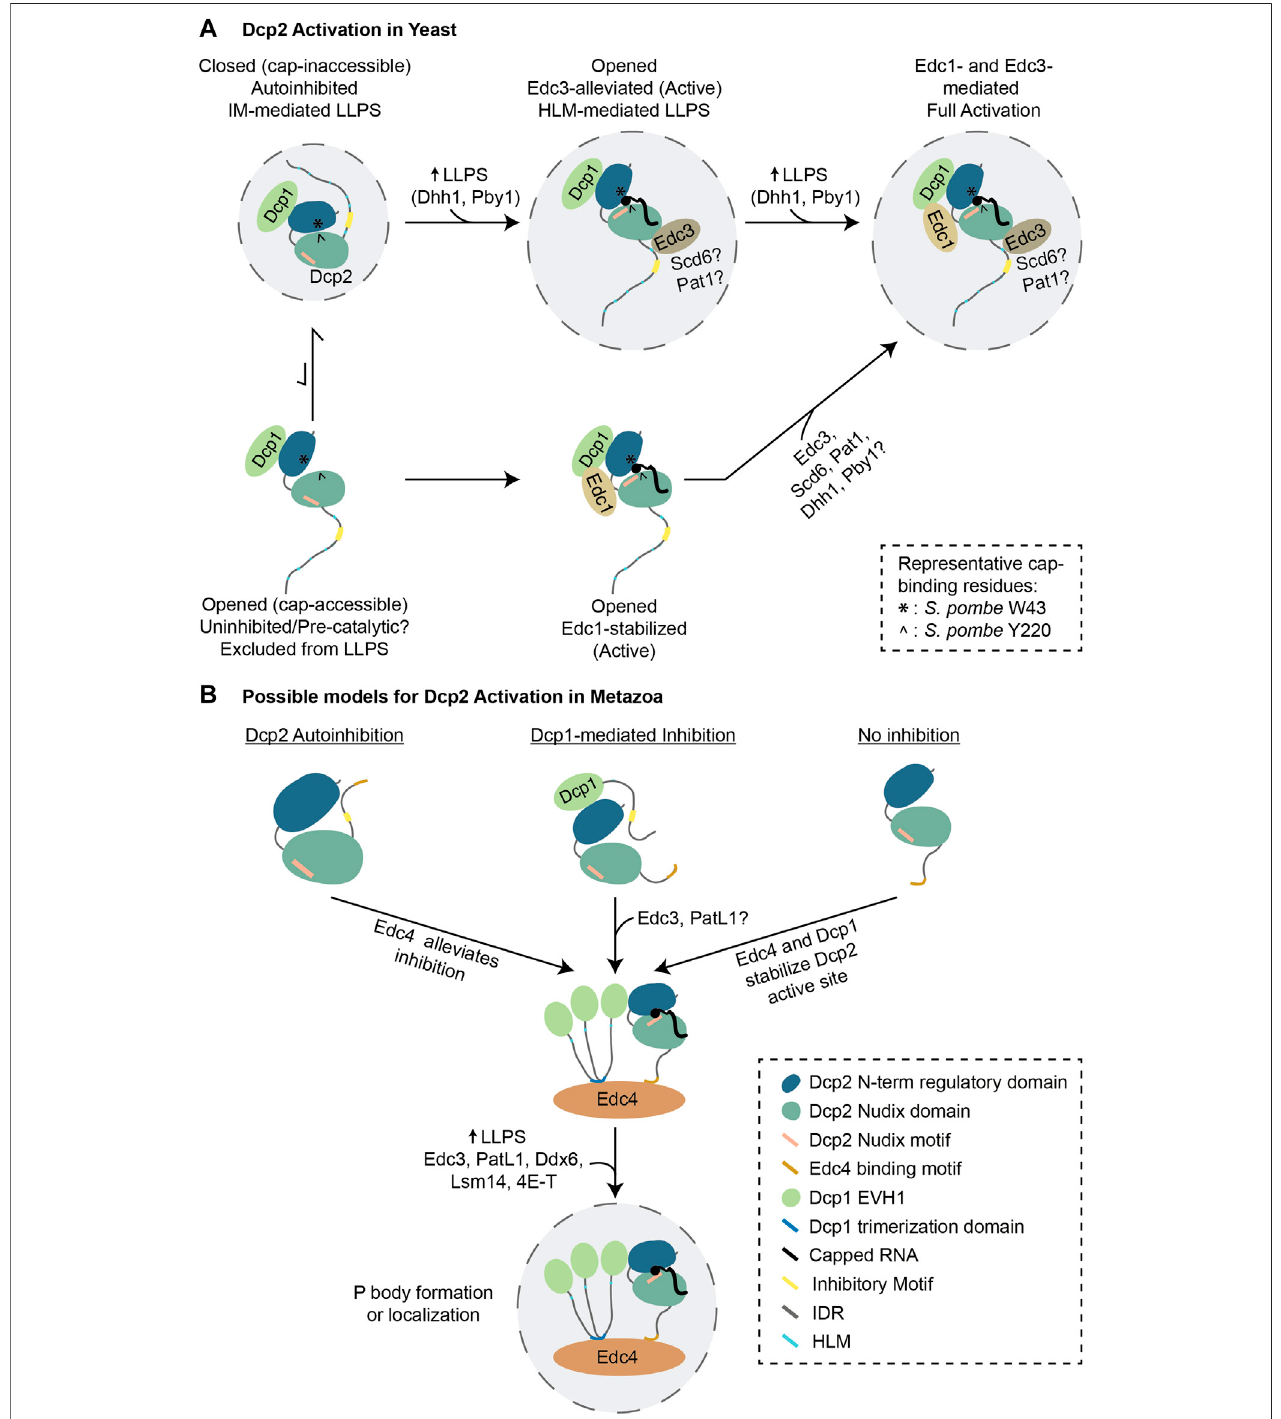
FIGURE 4 | Models of decappingactivation in yeast and metazoans. (A) The current model of Dcp2 activation from S. pombe is depicted. Dcp1/2predominantly exists in an autoinhibitedstatethatself-assembleintoLLPScondensatesandmaintainedbytheinteractionbetweenW49andY220.Edc3bindingtoDcp2HLMlikelyreorganizestheC-terminal IDR,allowingtheformationofanactivesiteinwhichW49andY220interactwiththecap,andactivatingDcp2insideLLPScondensates.Onitsown,Edc1maystabilizetheopened/ active conformation of Dcp2 or consolidate the formation of active site from a pre-catalytic conformation from outside of LLPS condensates. Edc1 can also stabilize the Edc3- alleviated conformation in LLPS condensates, contributing to full activation of Dcp2. (B) Hypothetical model of metazoan Dcp2 activation. It is currently unknown whether or not metazoan Dcp1/2 is regulated through autoinhibition. Since metazoan Edc4 promotes the interaction between metazoan Dcp1 and Dcp2, it may help to alleviate autoinhibition or promote the formation of active site on Dcp2. Other decapping activators might enable decapping by promoting phase separation and Dcp2 localization to LLPS condensates. Abbreviations: IDR = Intrinsically Disordered Region; HLM = Helical Leucine-rich Motif.